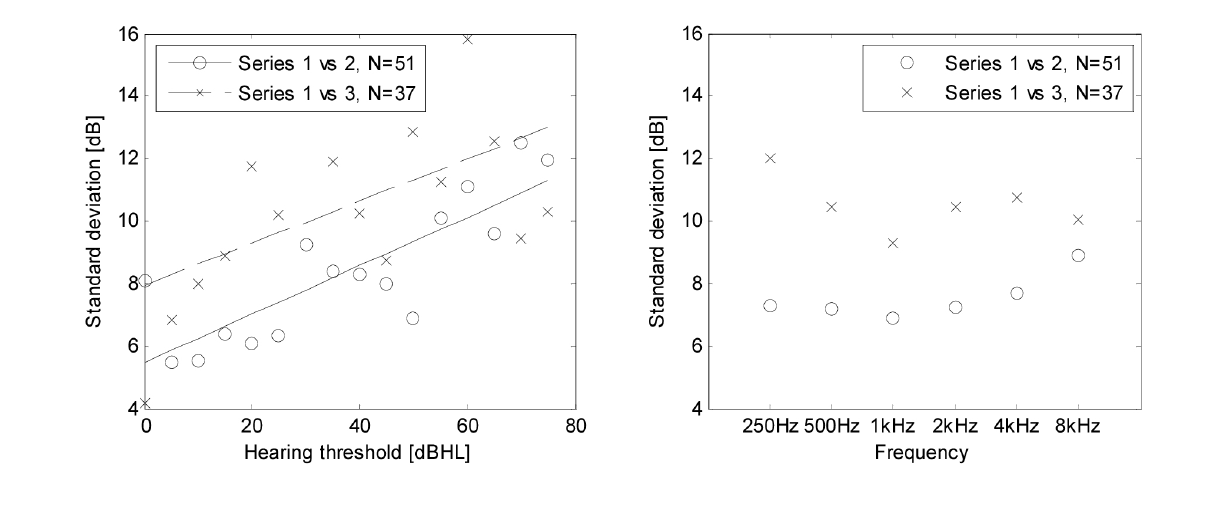
Figure 2. Standard deviation of the hearing threshold differences between the series calculated for the group of N subjects in relation to the hearing threshold evaluated in series 1 (left) and the frequency